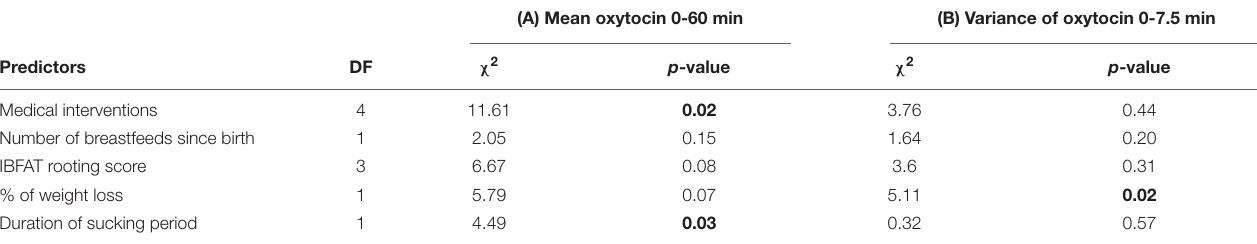
TABLE 6 | The relationship between (A) maternal mean oxytocin levels 0–60 min (log transformed) and (B) oxytocin variance 0–7.5 min of the observed breastfeed 2 days after birth and the following predictors; medical interventions during labor, number of breastfeeds since birth ( < 7 or > 8), IBFAT Rooting score, % of weight loss in infants since birth (covariate) and duration of the first sucking period